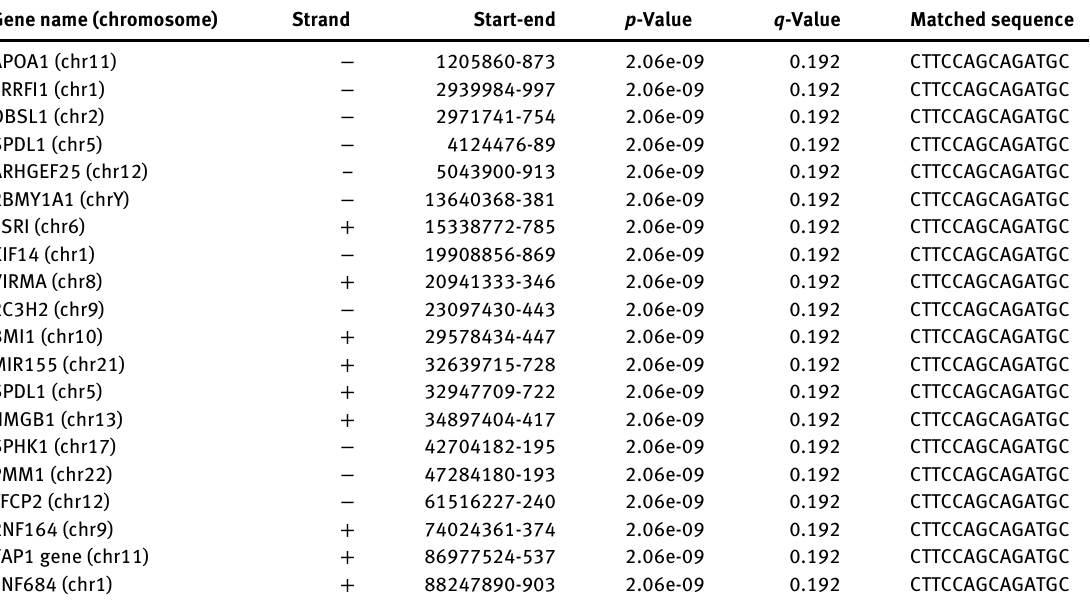
Table 2: Occurrences of the motif throughout the human